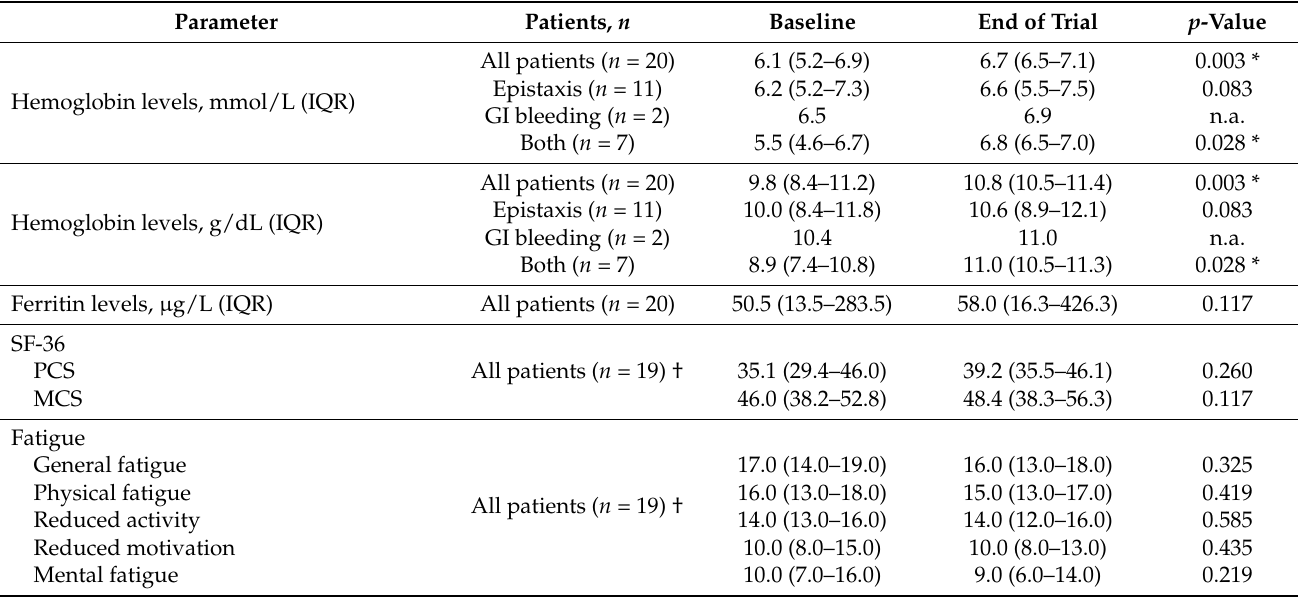
Figure 4. The primary outcome: median hemoglobin levels at baseline and the end of the trial. The bar is the median level. ( A ) For all patients. ( B ) For patients treated mainly for epistaxis. ( C ) For patients treated mainly for gastrointestinal bleeding. ( D ) For patients treated for both epistaxis and gastrointestinal bleeding. Table 3. Overview of the